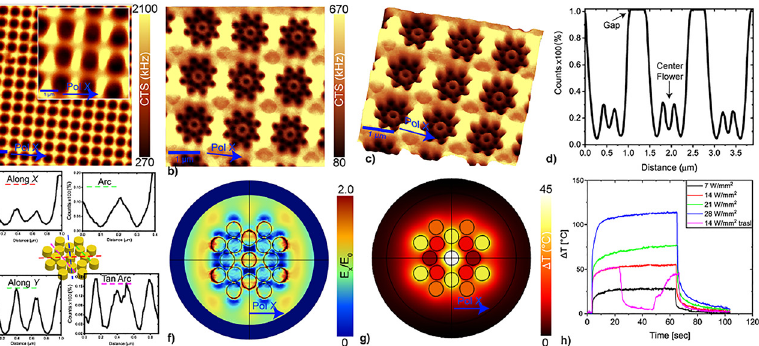
Figure 2: (a) Experimental confocal images of the plasmonic nano heater where the black zone denotes the nano flower. (b) Experimental scanning near-field optical microscope (SNOM) of the plasmonic nano heater 5 × 5 μ m where the black zone denotes the Au nano flower, (c) 2.5D view of micrograph (b). (d) Near electric-field profile on the averaged area 5 × 5 μ m and (e) near field distribution profiles along disks at different positions. (f) Normalized numerical electric field map and (g) near field thermal map of the proposed geometry using an intensity of 14 W ∕ mm 2 , (h) experimental macroscopic temperature at different laser ( 𝜆 = 532 nm) intensity for 60 s of irradiation. The purple line refers to a measurement acquired moving, after 20 s, the nano flower far away from the laser